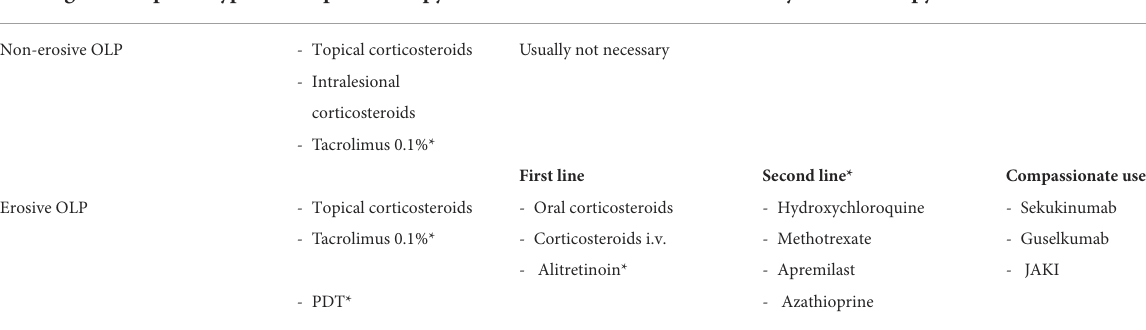
TABLE 1 Recommended therapies for oral lichen planus i .